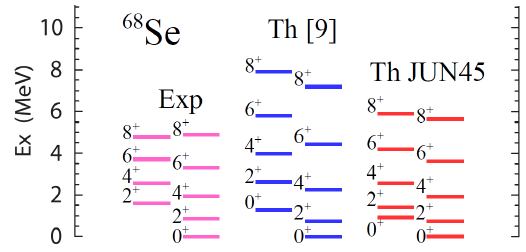
Figure 2. (Color online) Excitation energy spectrum of the g.s. band in 68 Se obtained in the pf 5 / 2 model space using the JUN45 and the interaction from [9] compared with the experimental re- sults